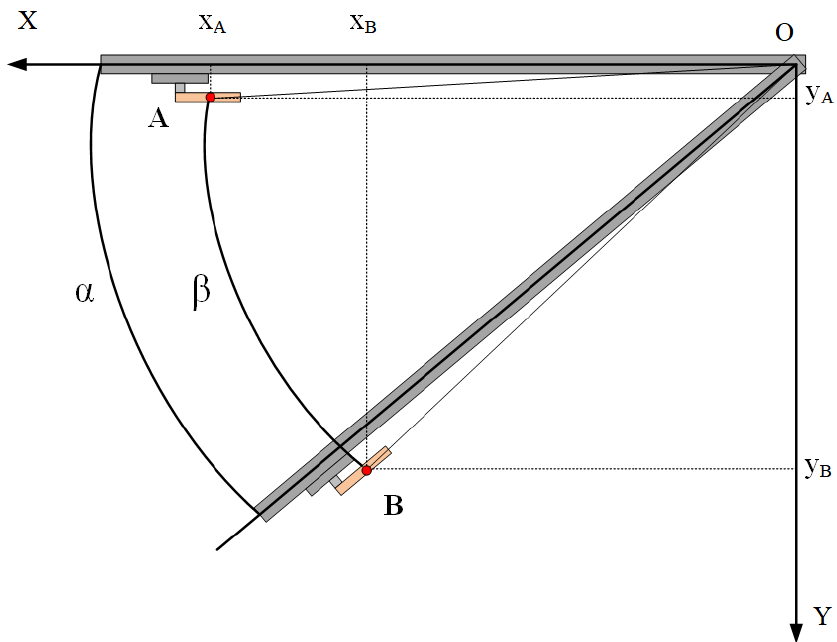
Figure 5. The schematic diagram of the door-opening track.